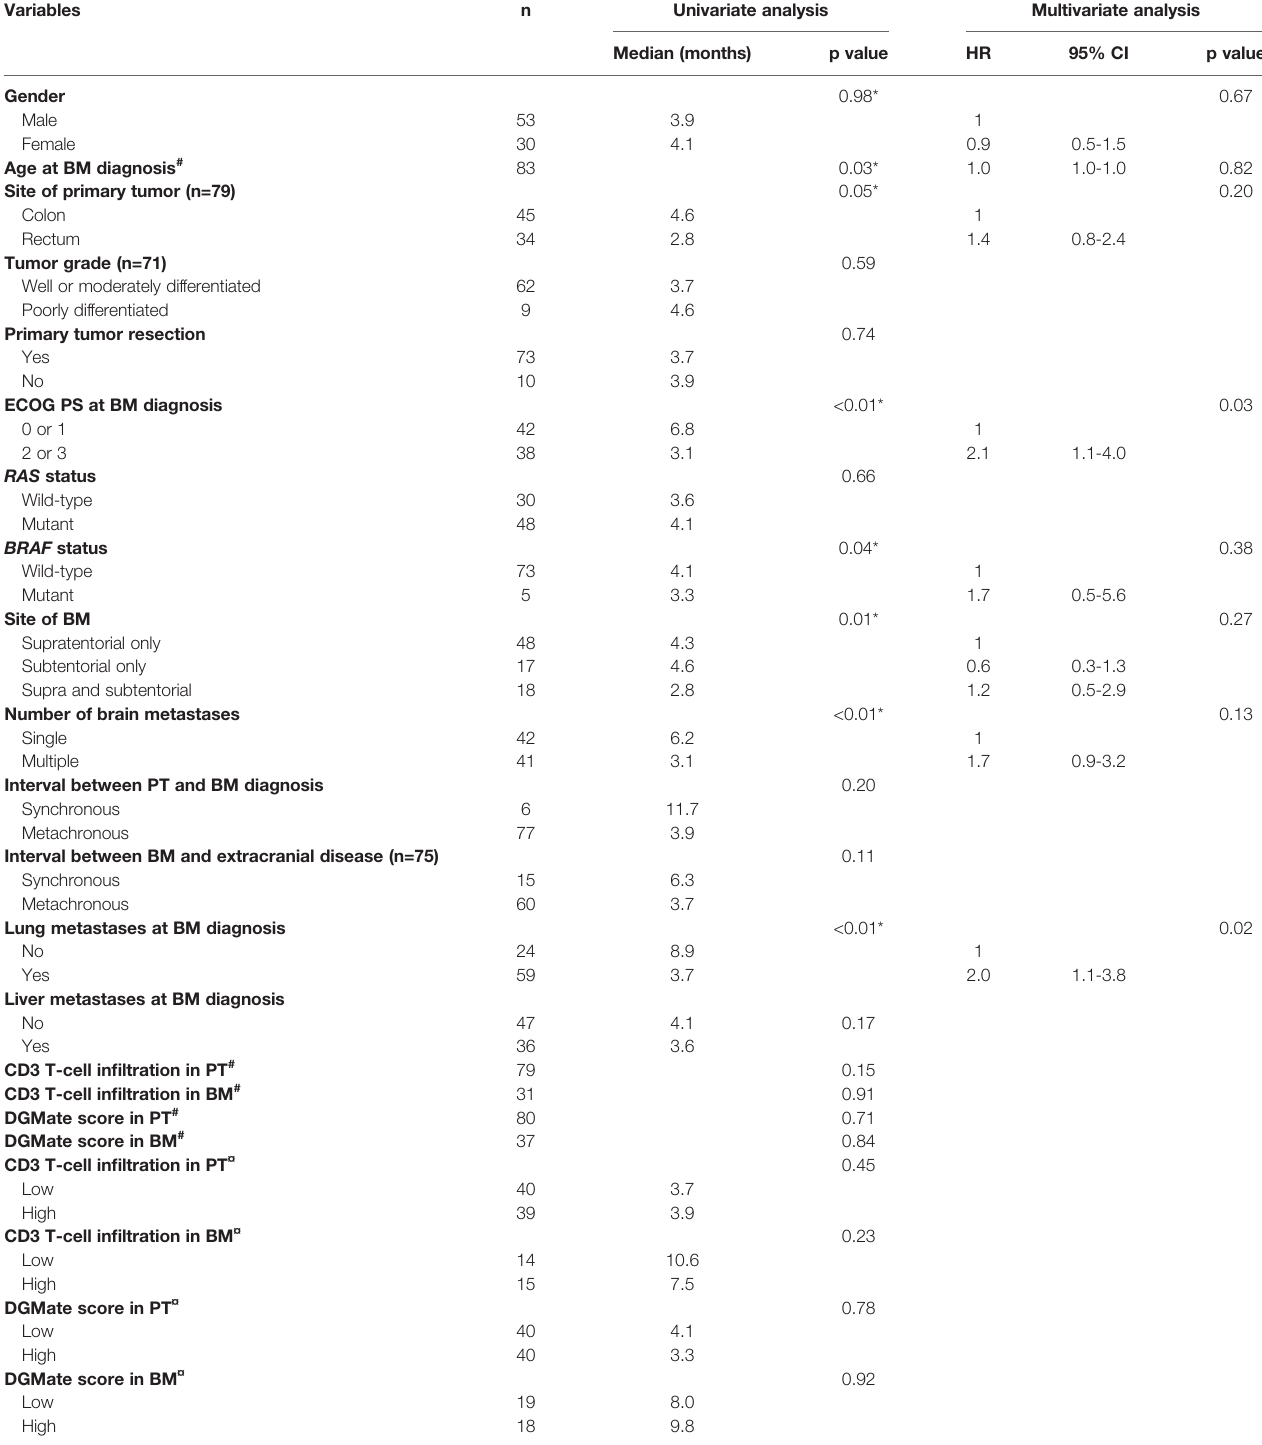
TABLE 4 | Prognostic factors of overall survival from brain metastases